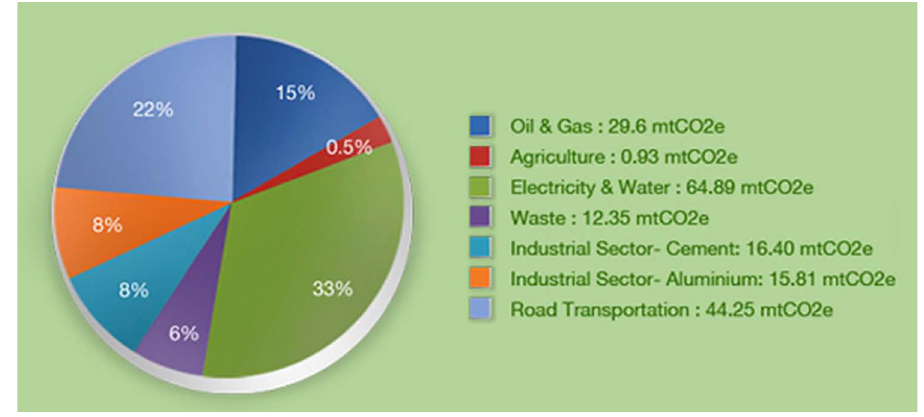
Figure 2. GHG Emission per Sector in UAE (Source: Mazumder,